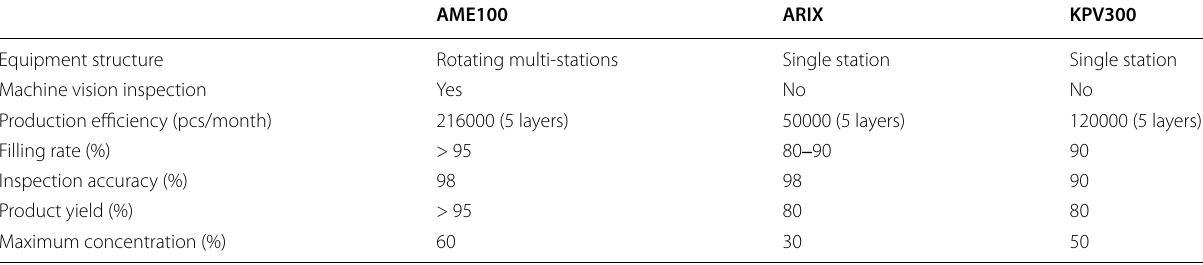
Table 2 Performance comparison of different equipment for diamond green segments